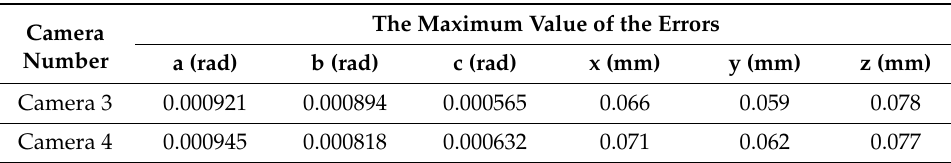
Table 6. The maximum values of the errors in 15 experiments.